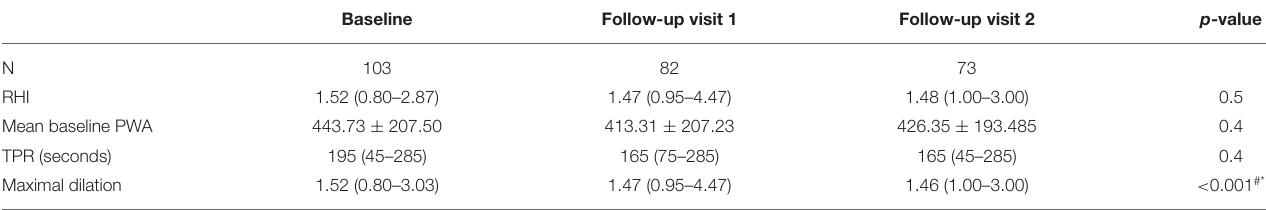
TABLE 5 | Endothelial function parameters during weight loss